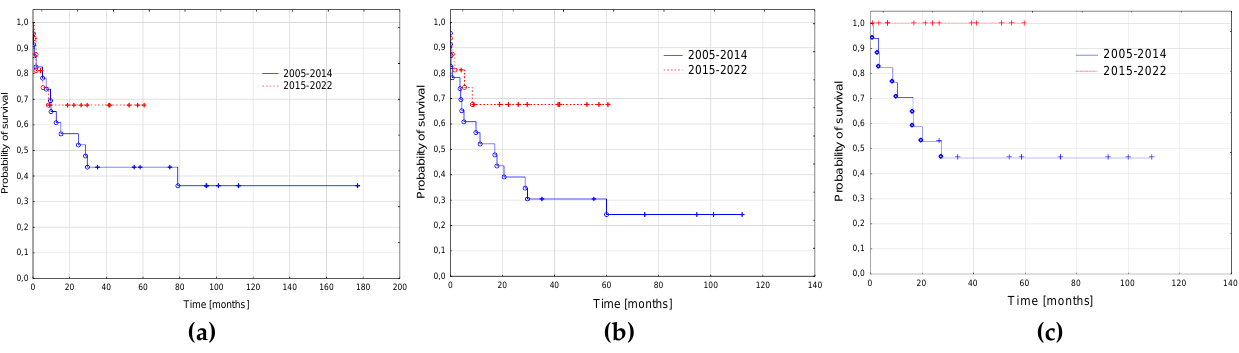
Figure 3. Survival curves in 2 periods: 2005-2014 and 2015-2022. (a) probabilities of 3-year overall survival: 2005-2014 – 0.43 ±0.1 ; 2015-2022 – 0.68 ±0.12 ; p=0.35 ( b ) probabilities of 3-year event free: 2005-2014 – 0.30 ±0.1 ; 2015-2022 – 0.67 ±0.12 ; p=0.07 (c) probabilities of 3-year relapse free survival: 2005-2014 – 0.46 ±0.11 ; 2015-2022 – 1.0; p=0.01